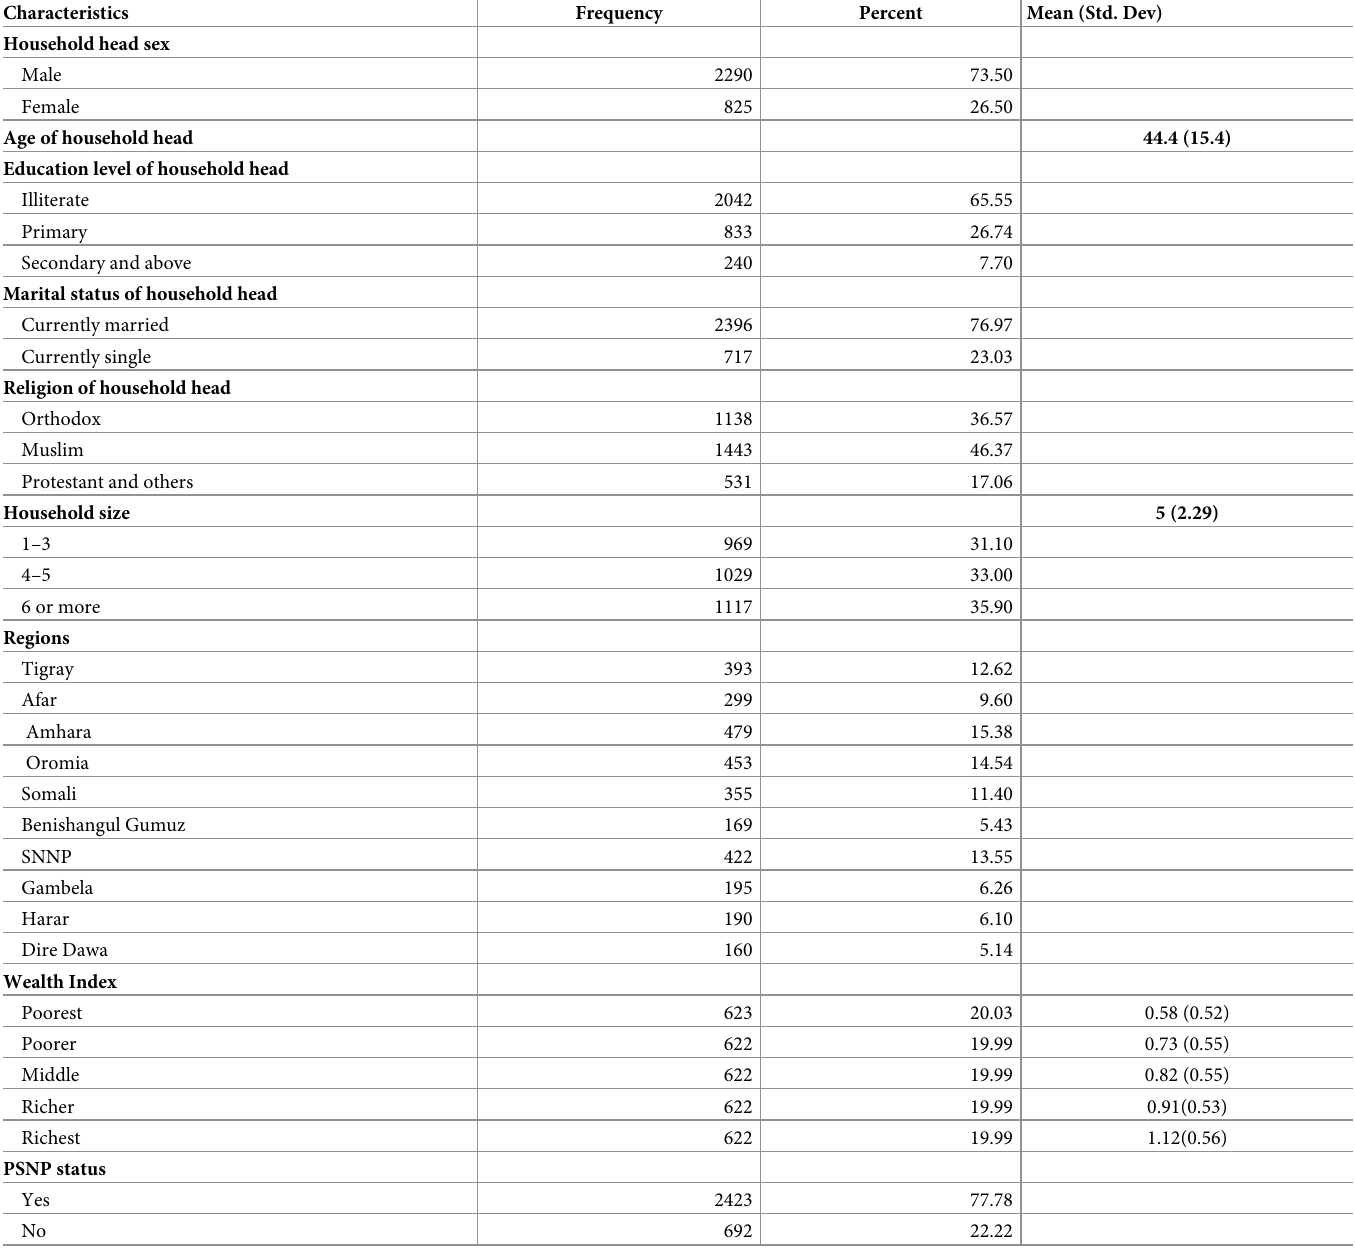
Table 1. Description of household demographic and socioeconomic